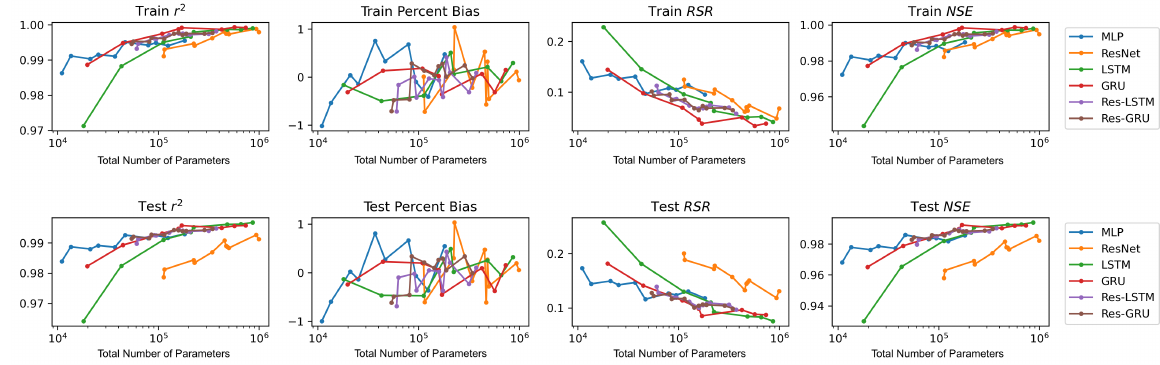
Figure 13. Model performance versus total numbers of parameters of the proposed models and their variants with varying structural